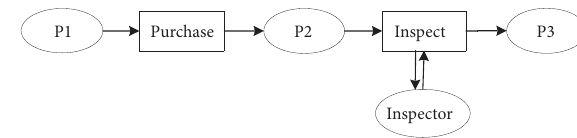
Figure 6: Subprocess CPN for PART0031 and PART0032.